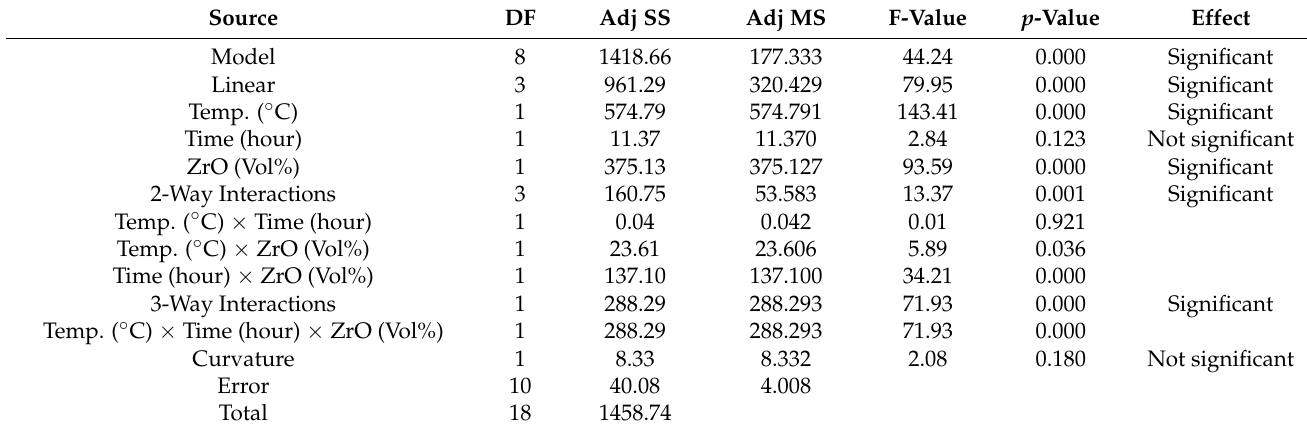
Table 7. The analysis of variance of hardness by full factorial.